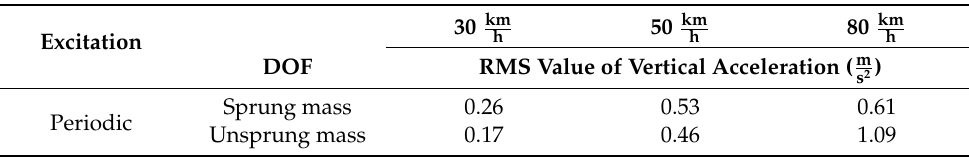
Table 7. The values of the peak accelerations of the sprung and the unsprung mass of the QC model for the single disturbance excitations.